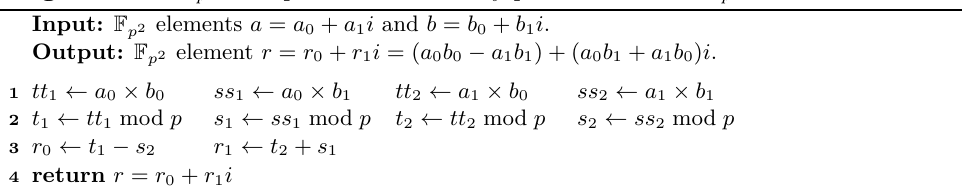
Algorithm 5: F -multiplication with 4-way parallelization at F p p 2